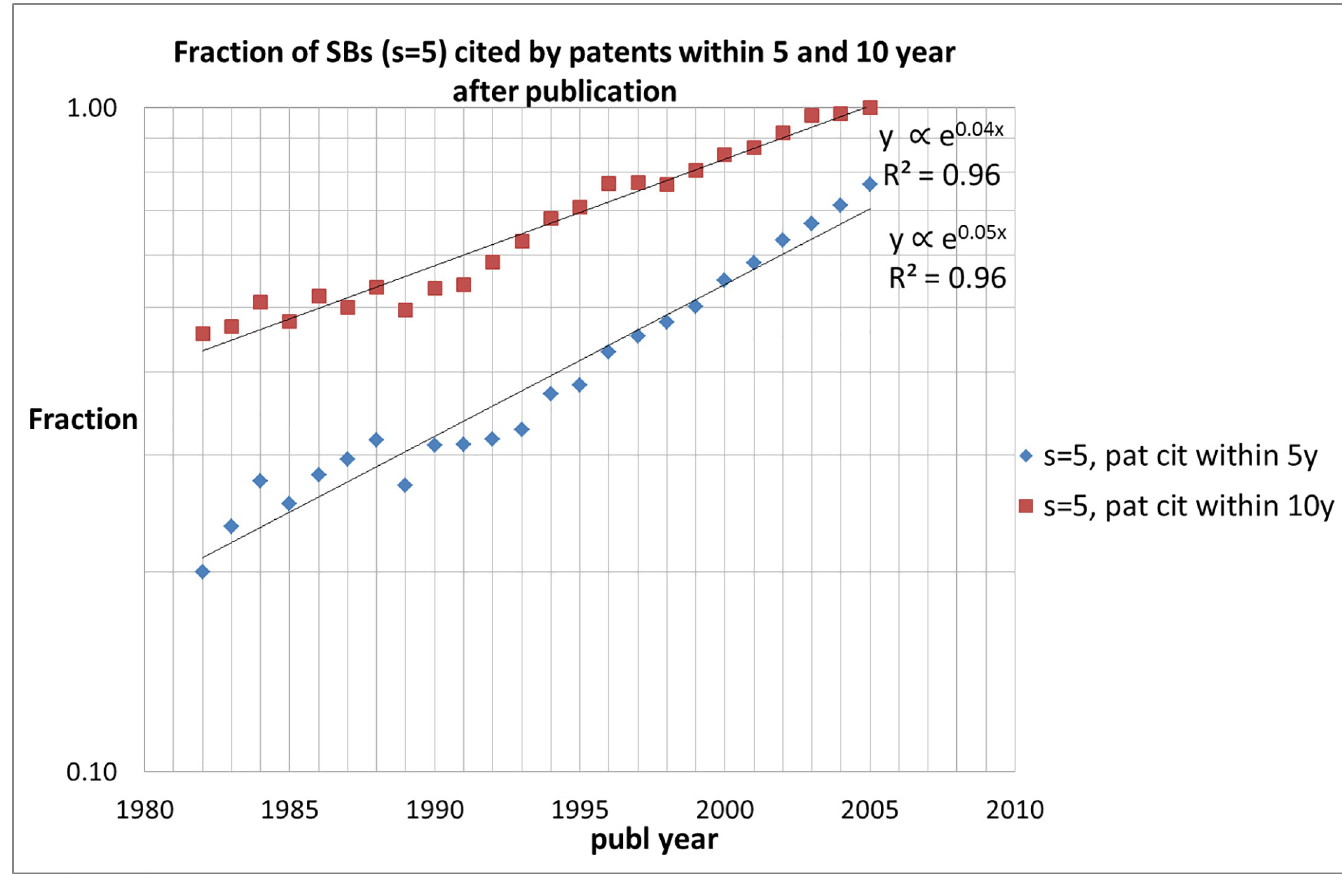
Fig 14. Fraction of SBs with s = 5 that are cited by patents within 5 and 10 year after publication of the